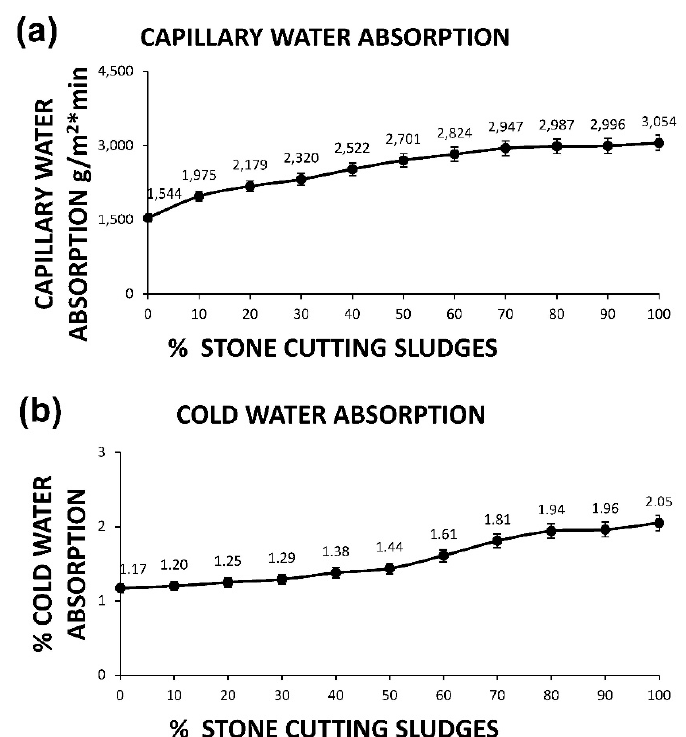
Figure 2. Graphs of the physical tests of the different groups of ceramic samples as a function of the percentage of stone cutting sludges. ( a ) Capillary water absorption and ( b ) cold water absorption.